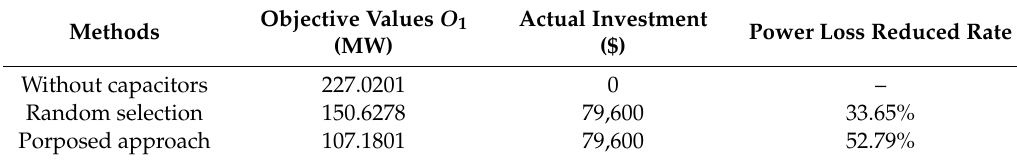
Table 6. Results for each candidate matter of M = 80,000 case on the IEEE 244-bus system.